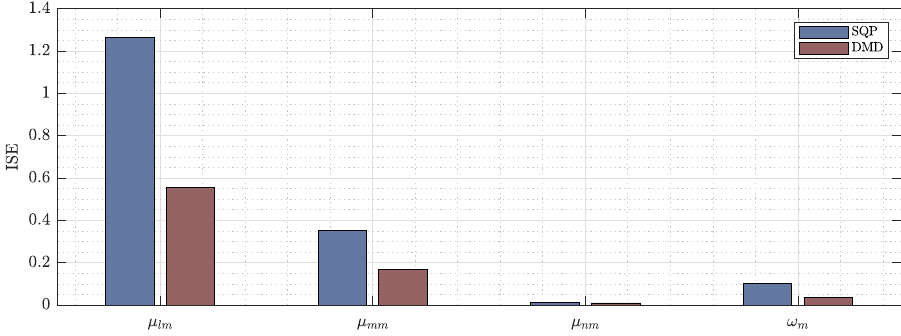
Figure 6. Integral square error of the identified models using Euler–Lagrange with sequential quadratic programming (SQP) and dynamic mode decomposition (DMD)